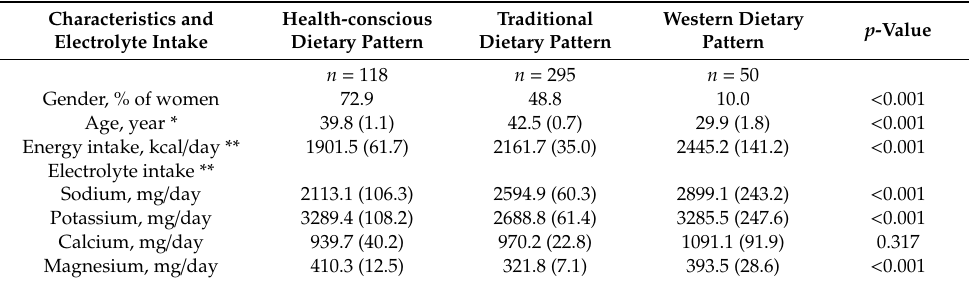
Table 5. Electrolyte intake among dietary patterns adjusted for gender and age.